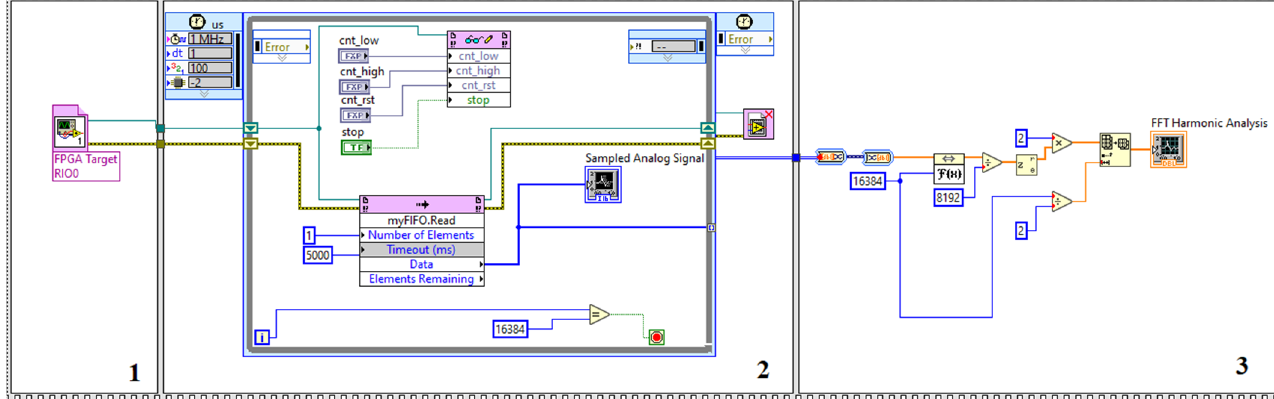
Figure 14. LabView code used for the design of the proposed measurement system. 1. First frame of the code embeds the VHDL code; 2. Second frame is a loop structure with 1MHz clock; 3. Third frame is the FFT analysis.